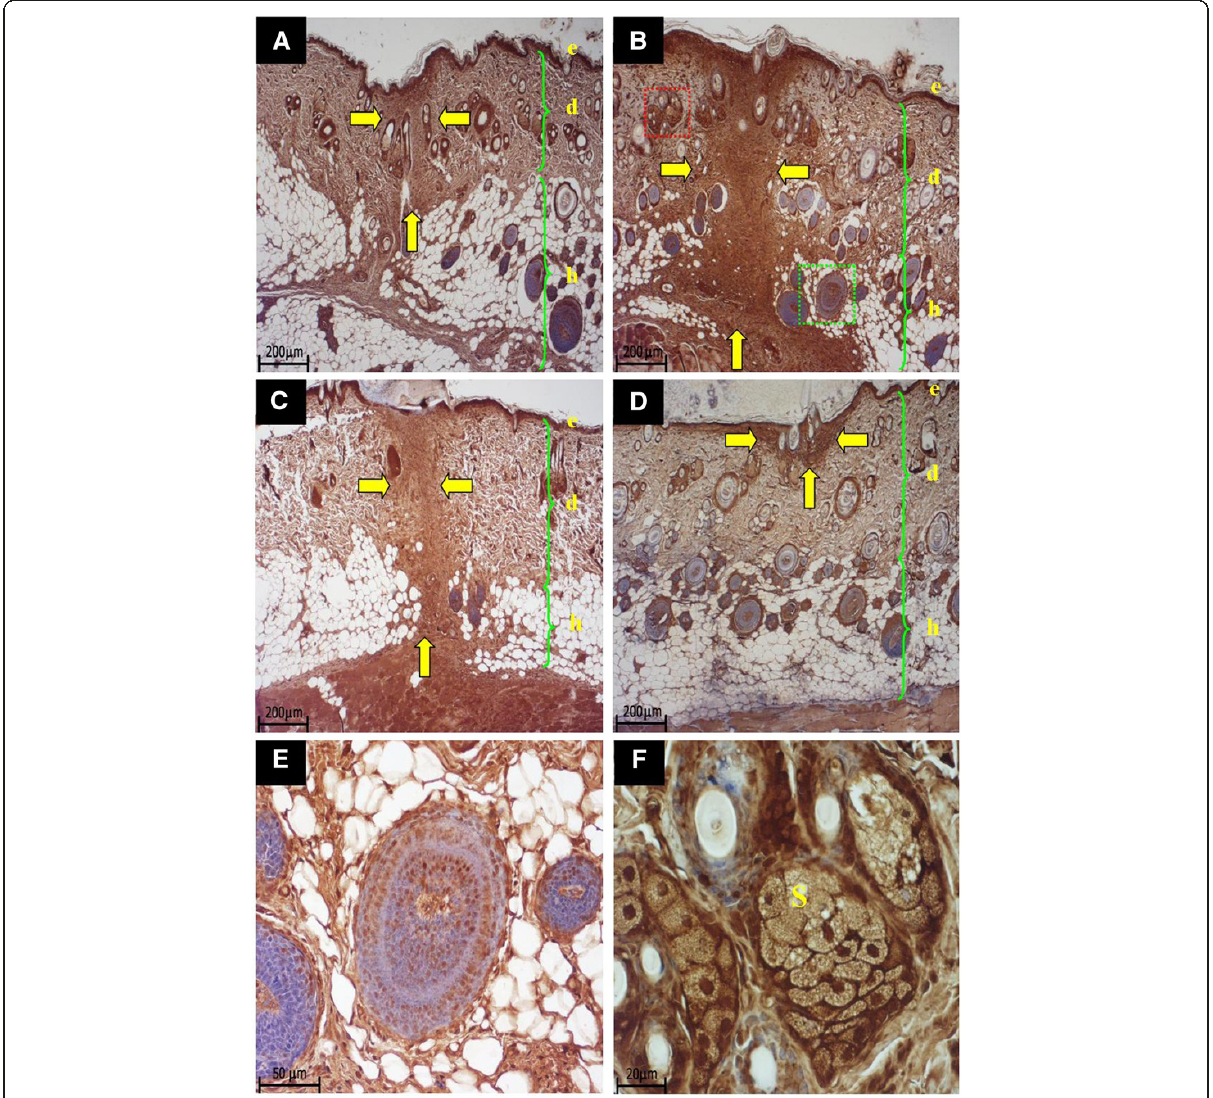
Figure 5 A-F. Sections from the dorsal skin of the four groups, following treatment for 14 days. Sections were immunostained with anti- ER- β antibody. Wound sites in A, B, C, D are indicated by yellow arrows. (x4). A = sham-operated group, B = Ovx group , C = Ovx+EB group, D = Ovx+YCJ group. E. Higher magnification (x20) of the green boxed area seen in B and showing strong ER- β positive immunostaining of the hair follicle. F. Higher magnification (x40) of the red boxed area seen in B and showing strong ER- β positive immunostaining of the sebaceous glands. e = epidermis, d = dermis, h = hypodermis; S = sebaceous